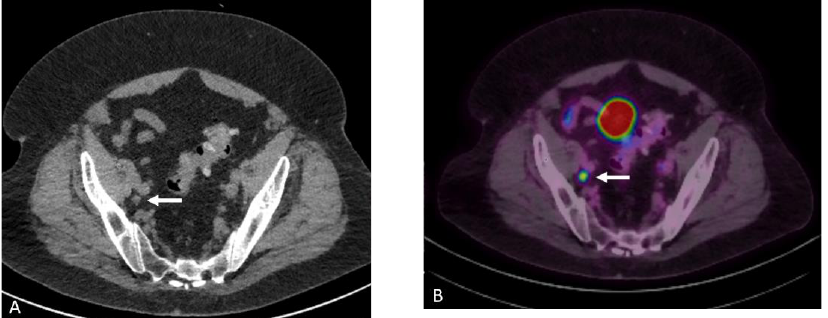
Figure 15. Seventy-seven-year-old male with history of prostate cancer, status post-prostatectomy, now with biochemical recurrence. NECT ( A ) and corresponding fused PET/CT ( B ) images show a sub-centimeter right external iliac lymph node which shows moderate radiotracer uptake concerning for nodal metastatic disease.